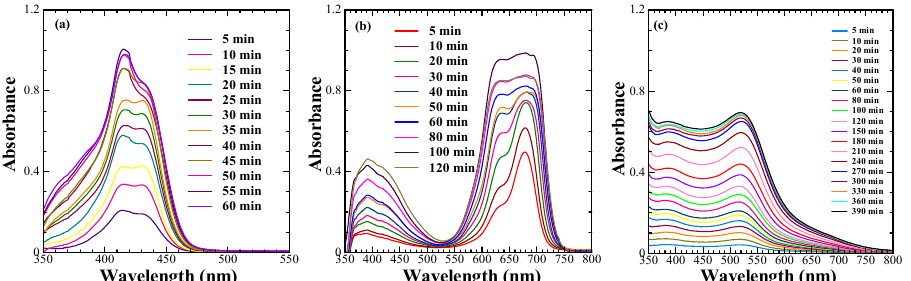
Figure 2. Adsorption behaviour of sensitizing dyes such as NK-3705 ( a ), SQ-140 ( b ), and Z-907 ( c ) on 6 µm thick transparent TiO 2 .